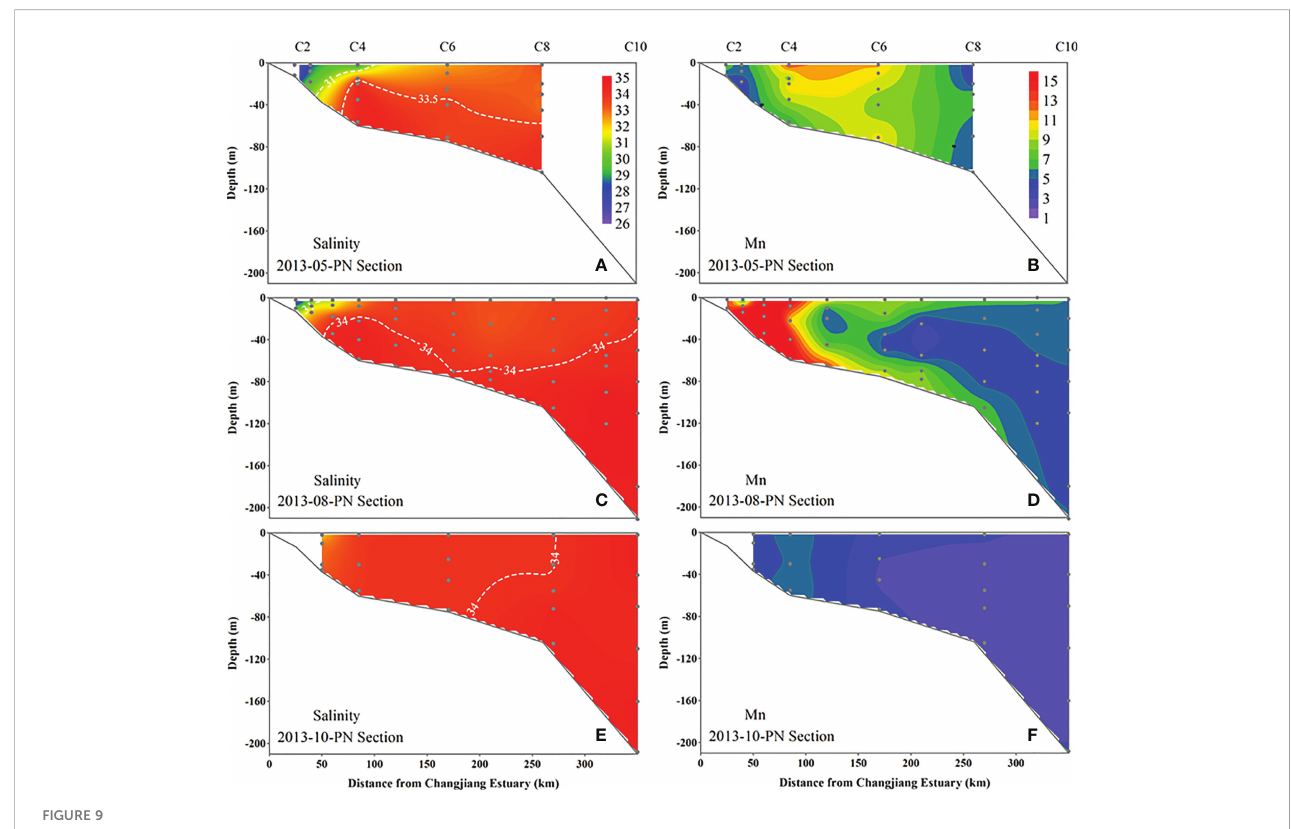
FIGURE 9 Seasonal variations of salinity (A, C ,E) and dissolved Mn ( nM , B ,D, F) (nM) across the PN section.